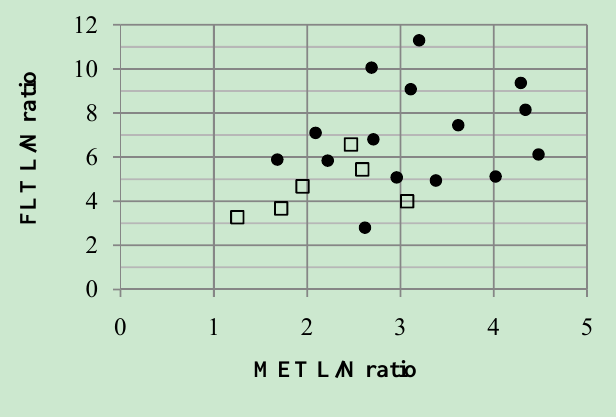
Figure 3. Linear regression analysis of L/N ratio between MET and FLT. There is no significant correlation between the individual L/N ratio of MET and FLT ( r = 0.41, p = 0.064). Closed circles ( ● ) indicate the cases with recurrent glioma and open squares ( □ ) indicate the cases with necrotic lesion.